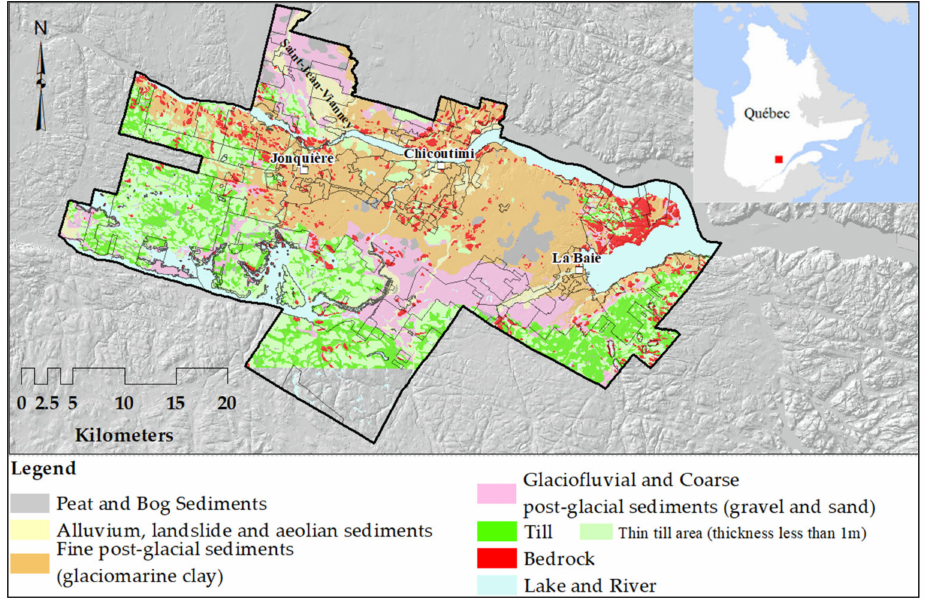
Figure 5. Saguenay study area: surficial geology map (modified from Daigneault et al. [33]),